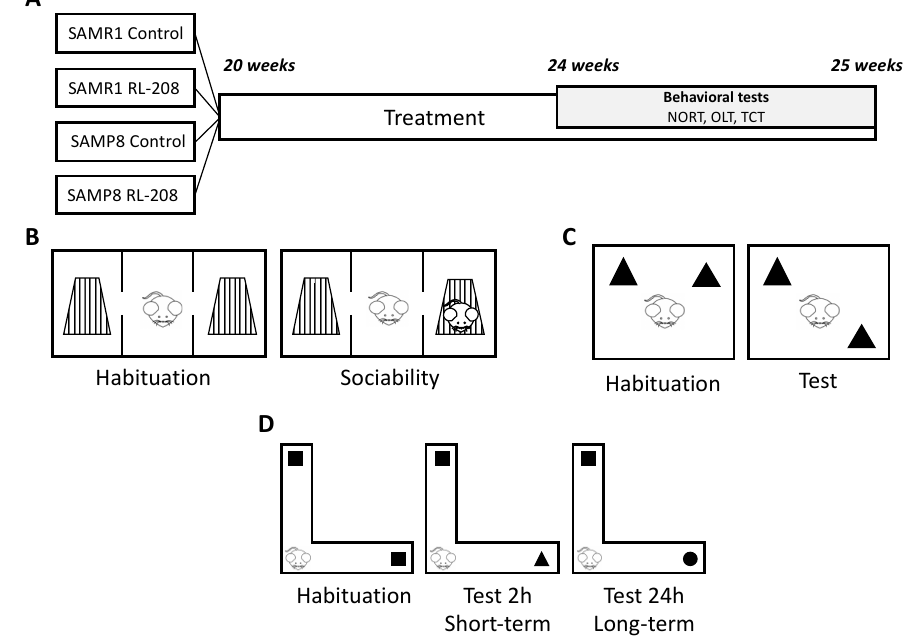
Figure 1. Scheme of experimental design (A) , Scheme of Three Chamber Test (TCT) (B) , Scheme of Object Location Test (OLT) (C) , and scheme of Novel Object Recognition Test (NORT) (D) .